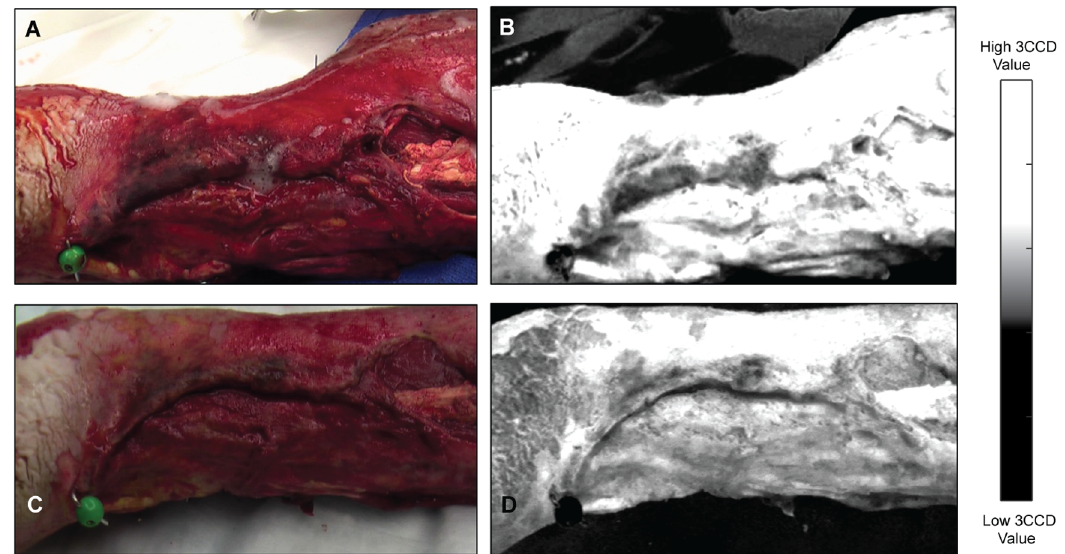
Fig 2. Regular 3CCD images (color) collected during a civilian trauma case (Emory/Grady) and the corresponding contrast enhanced images (grayscale); in this case, the wound dehisced. First de´bridement (A) from a healed wound and its corresponding contrast enhanced image (B). Last de´bridement (C) from the same case and the corresponding enhanced image (D). Notably, the wound bed 3CCD values are decreased at the last de´bridement (darker in color) when compared to the first de´bridement (lighter in